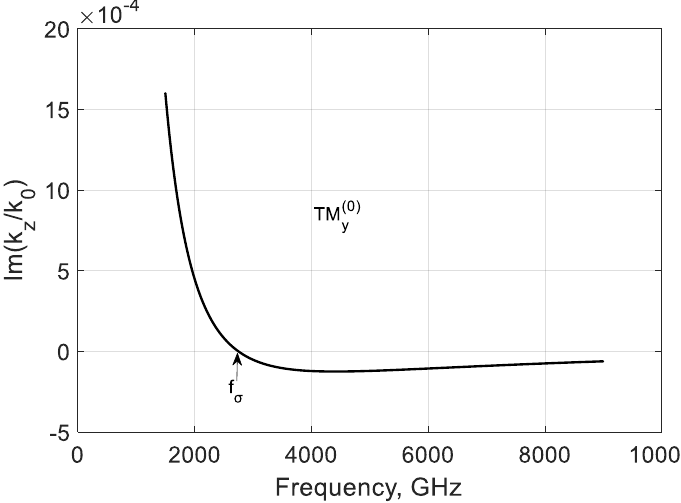
Figure 10. Normalized imaginary part of the modal propagation constants k y z / k 0 of the first TM backward mode of a graphene H-waveguide of the height b = 0.01 mm, width 2 a = ∞ , ε r = 3.84 , and µ σ τ = 1 ps. r = 1. Parameters used for calculation of g are from Ref. [21]: T = 300 K, E F = 40 meV, and